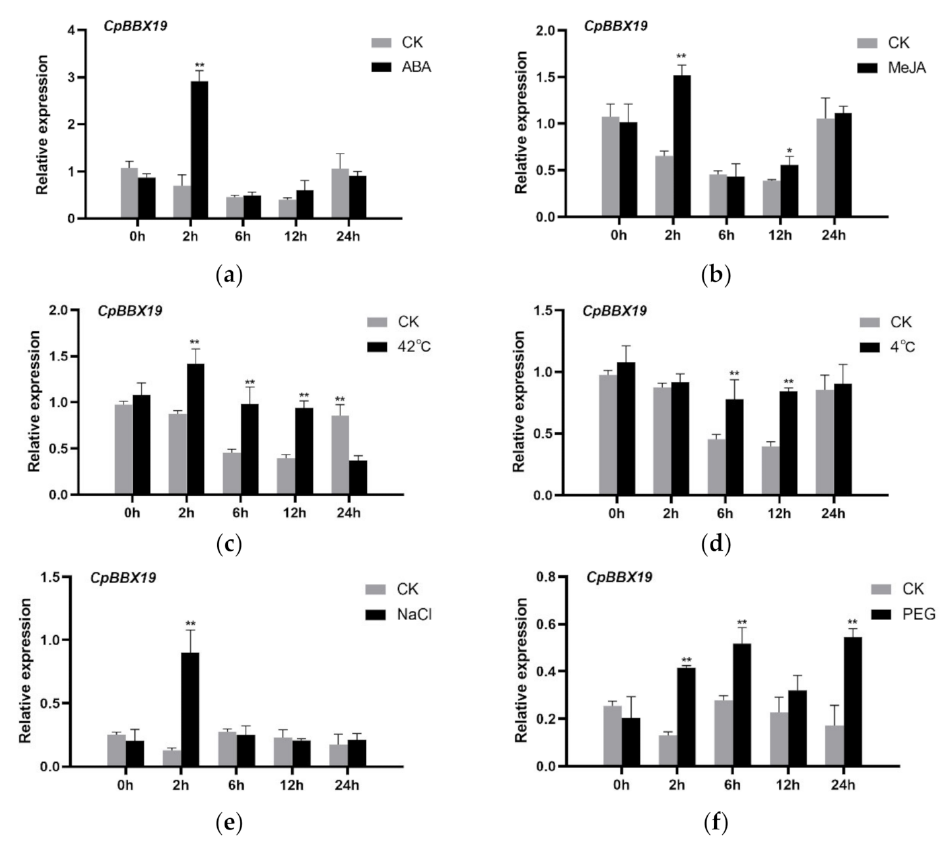
Figure 4. Expression profiles of CpBBX19 in response to abiotic stress and hormone treatments. Six-leaf stage wintersweet was exposed to ( a ) 50 µ M ABA, ( b ) 100 µ M MeJA, ( c ) 42 ◦ C, ( d ) 4 ◦ C, ( e ) 300 mM NaCl, and ( f ) 50% PEG-6000 treatments. RNA was extracted from the leaves at 0, 2, 6, 12, and 24 h after treatment. CpActin was used as the internal reference gene. Data represent the mean of three biological repeats ± SD. Error bars indicate standard deviation. * p < 0.05, ** p < 0.01.